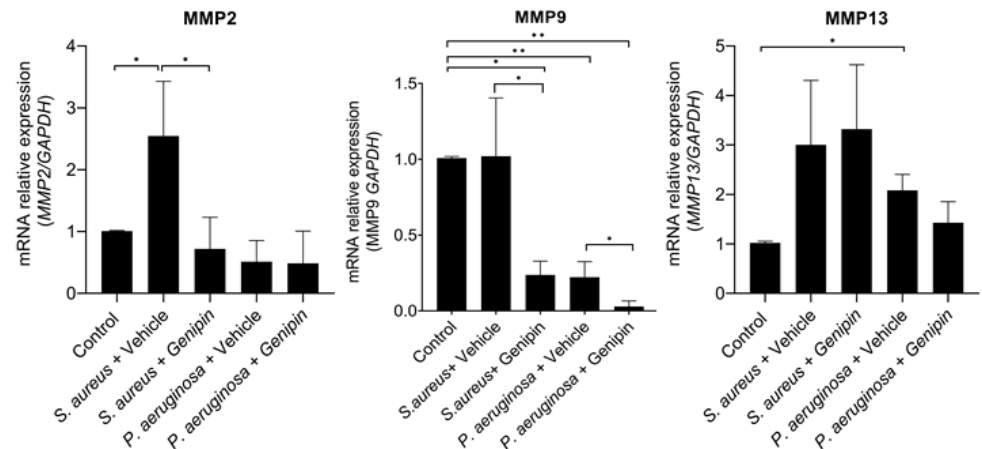
Figure 4. The expression of MMPs in the infected corneas was decreased in infected corneas treated with genipin. Corneas infected with S. aureus or P. aeruginosa were treated with either vehicle solution or genipin for 48 h. Total RNA was extracted and the mRNA expression levels of MMP2, MMP9, and MMP13 were evaluated with qPCR. Data are average mRNA expression levels relative to GAPDH ± standard deviation. A total of five corneas were used for each experimental group and all samples were examined in triplicates * p < 0.05, ** p < 0.01, comparing bracketed groups.